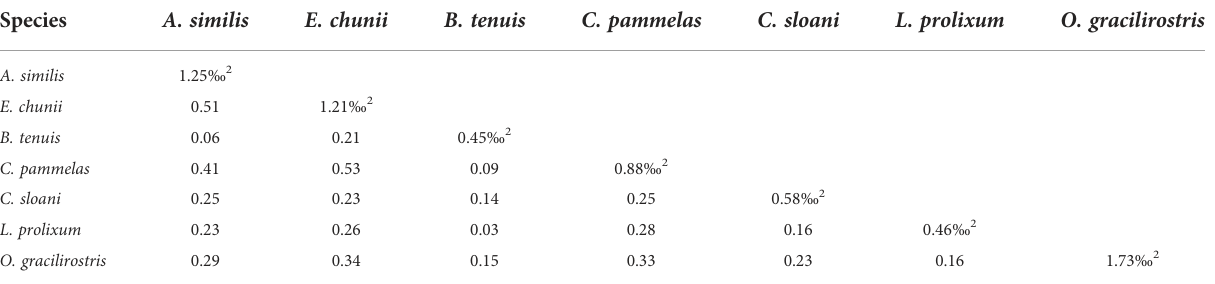
TABLE 6 Common micronekton trophic SEAc( ‰ 2 ) and overlap.